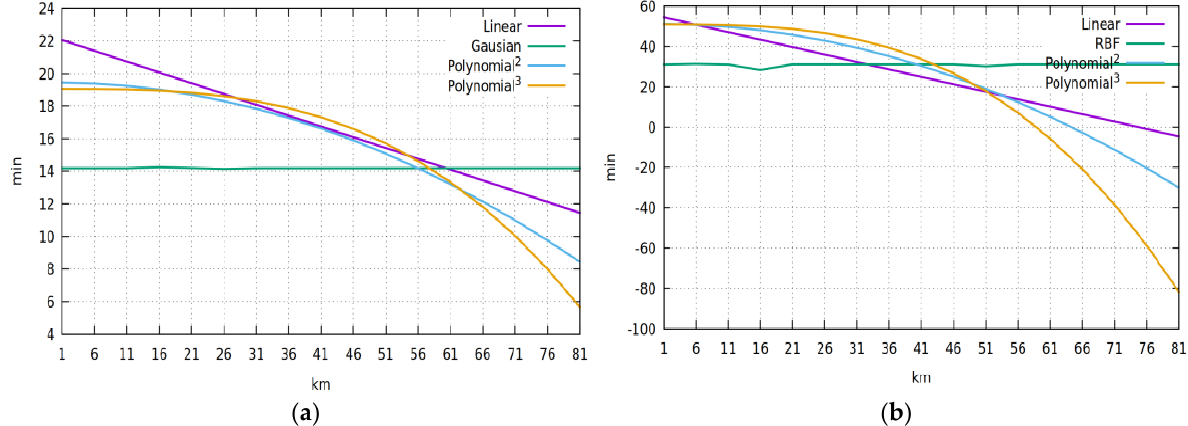
Figure 10. Plot of estimated time of field personnel in the ( a ) the left direction and ( b ) right directions on the motorway based on response time algorithm. SVR classifier response time prediction over distance.